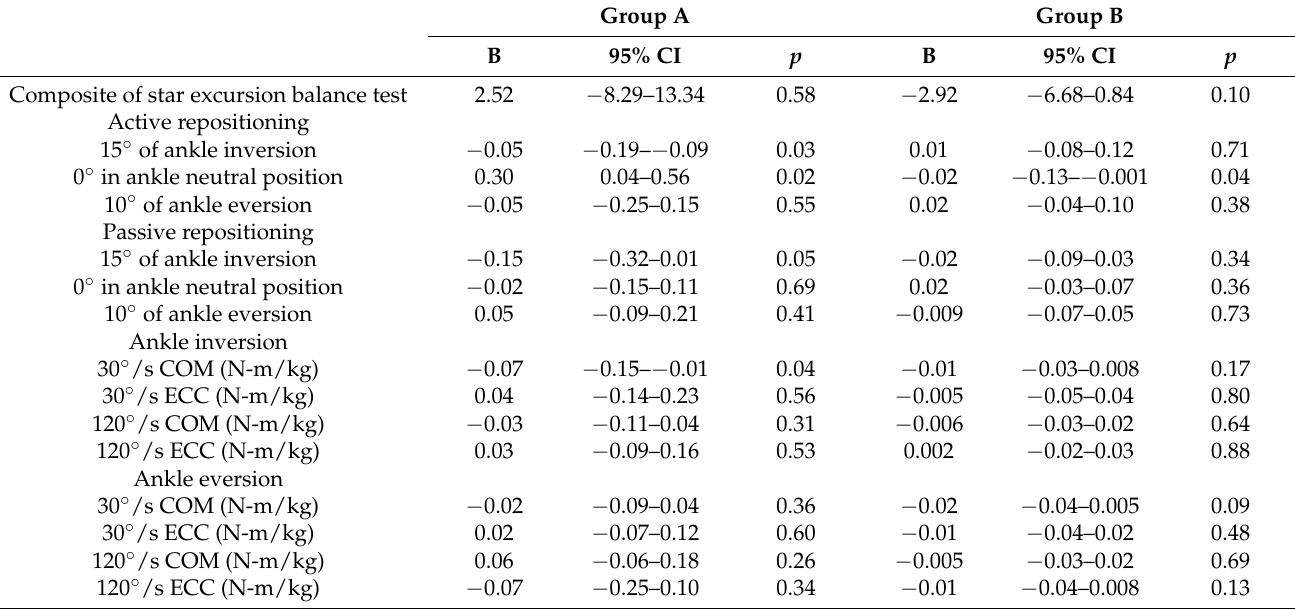
Table 3. The main outcome measurements in two training groups using linear regression